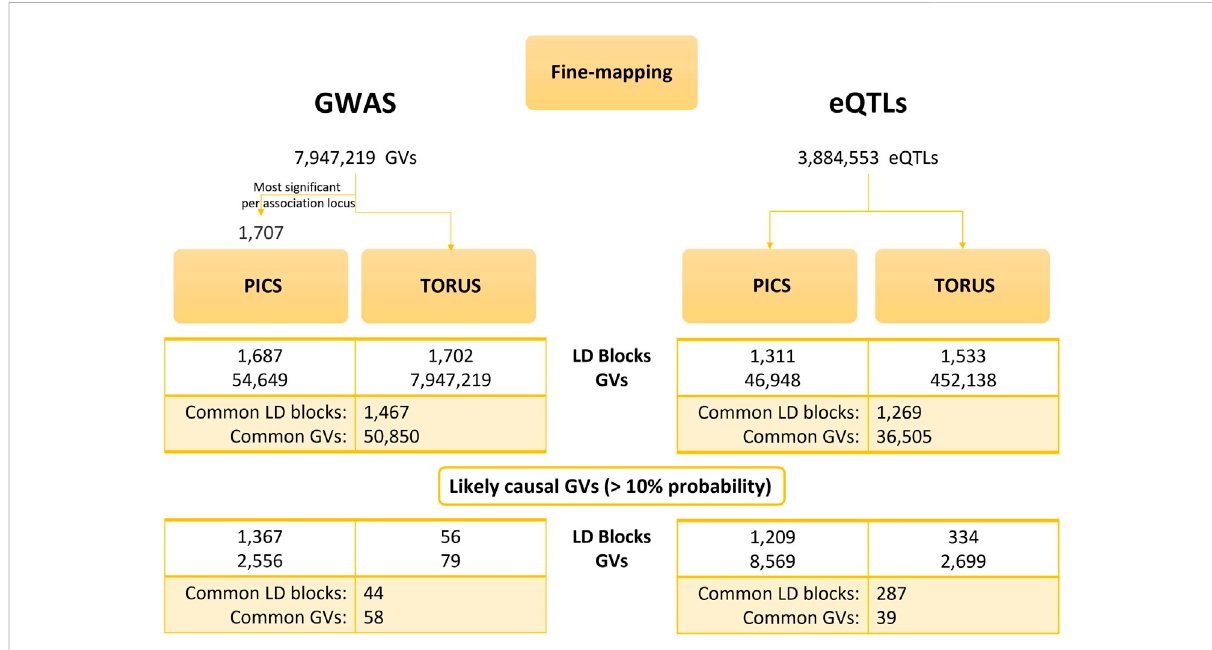
FIGURE 2 Results of PICS and TORUS fi ne-mapping analysis. Comparison of PICS and TORUS fi ne-mapping outcomes at GV and LD block level for both GWAS and eQTL datasets. PICS, Probabilistic Identi fi cation of Casual SNPs; GVs, genetic variants; LD, linkage disequilibrium; GWAS, genome-wide association studies; eQTLs, quantitative trait